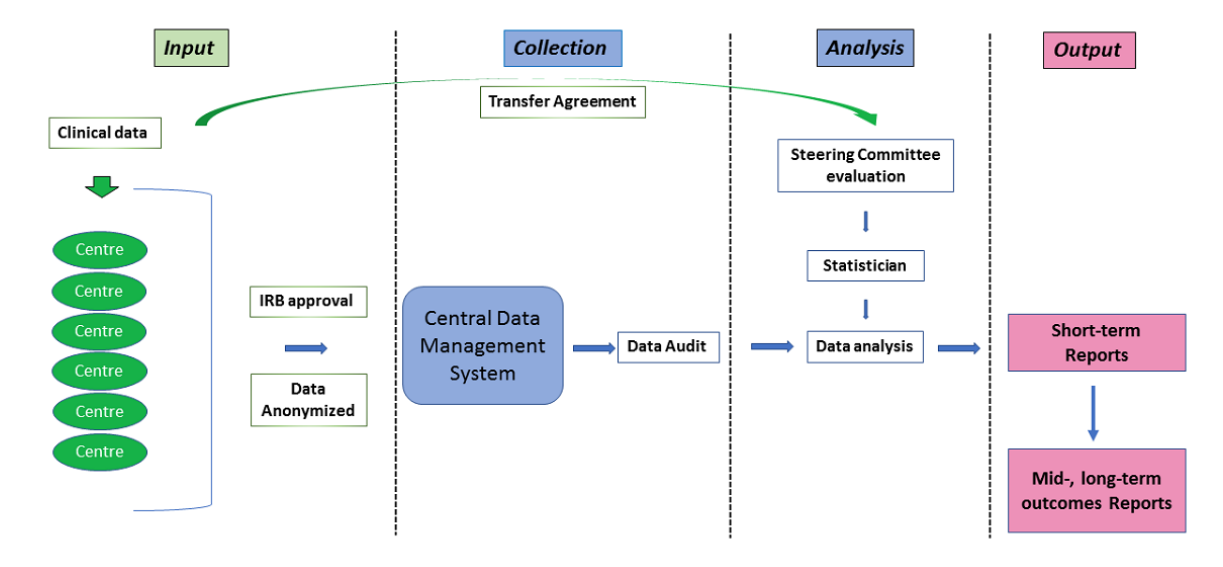
Figure 1. Operational flow diagram of the CROES-UTUC (Clinical Research Office of the Endourology Society for urothelial carcinomas of the upper tract) registry. Colors indicate the different levels of data input, management, and output as well as the interaction directions among them. Green color indicates external sources of information (participating centres); blue colour indicates central registry office tasks; pink/blue color indicates a combination of centres and central office registry output. IRB: institutional review